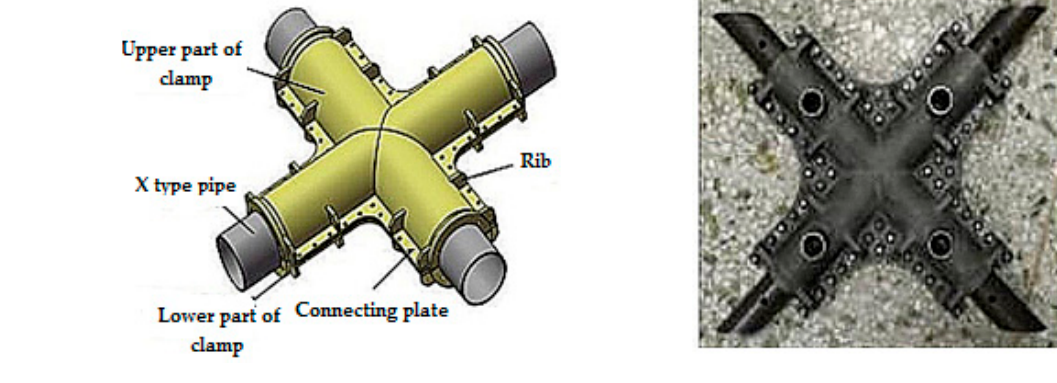
Figure 1. X-type grouting clamps [15].